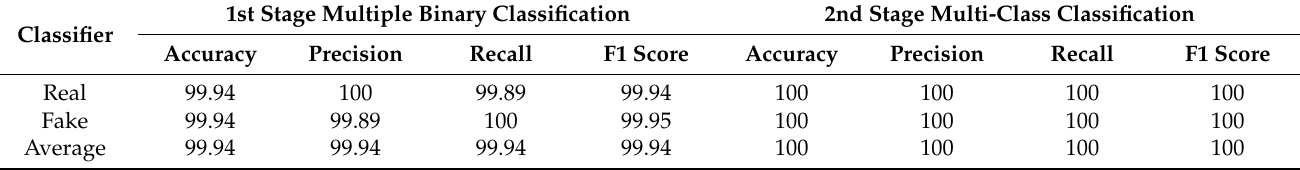
Table 5. Classification Accuracy of the Proposed Model using ISOT Dataset.